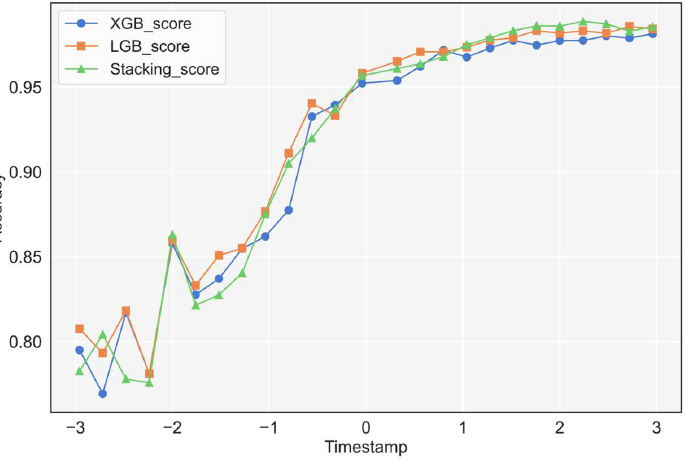
Figure 14. Comparison diagram of lane-changing intention recognition accuracy of each model at different times.